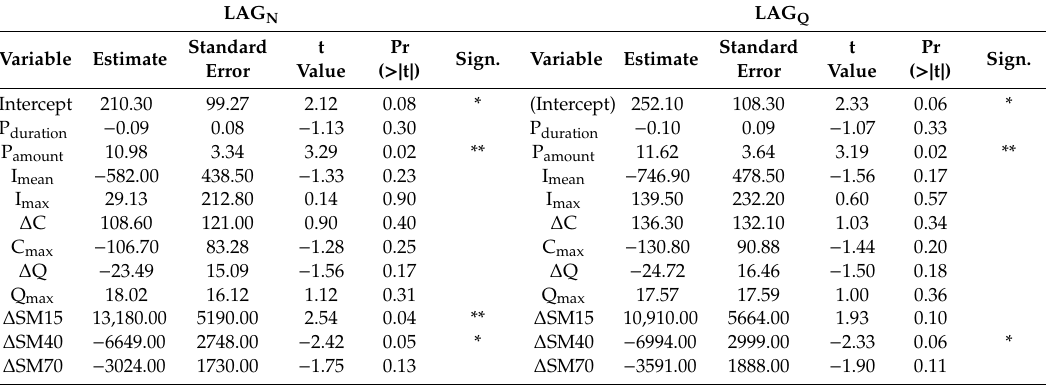
13,180.00 5190.00 0.04 0.10 ∆ SM40 − 6649.00 2748.00 − 2.42 0.05 * ∆ SM40 − 6994.00 2999.00 − 2.33 0.06 * ∆ SM70 − 3024.00 1730.00 − 1.75 0.13 ∆ SM70 − 3591.00 1888.00 − 1.90 0.11 ** p -value < 0.05, * p -value <